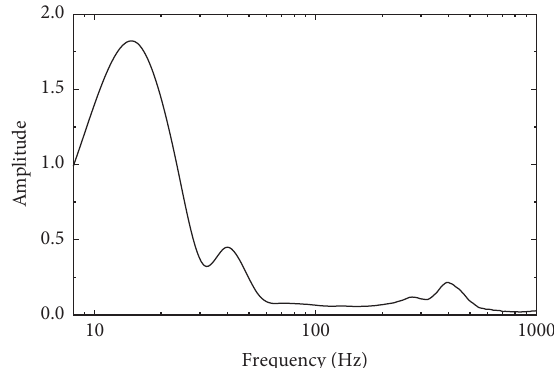
Figure 13: Distribution of vibration wave energy in vibrational wheel.